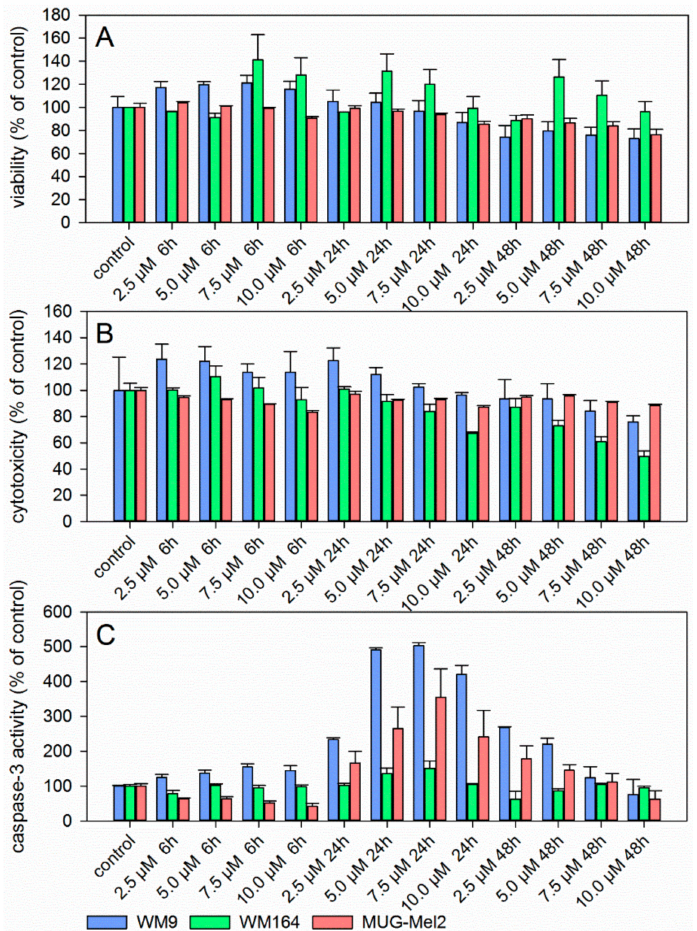
Figure 2. Results of the ApoTox-Glo™Triplex assay showing cell viability ( A ), cytotoxicity ( B ), and caspase 3/7 activity ( C ) in different melanoma cells after 6 h, 24 h, and 48 h treatment with 6 (mean ± SEM, n = 6). Staurosporine (10.0 µ M) served as positive control for apoptosis induction (caspase activity after 24 h: WM9: 724.8 ± 3.8%; WM164: 898.6 ± 18.4%, and MUG-Mel2: 637.7 ± 64.8% and after 48 h: WM9: 181.1 ± 4.1%, WM164: 226.6 ± 22.5%, and MUG-Mel2: 314.1 ±